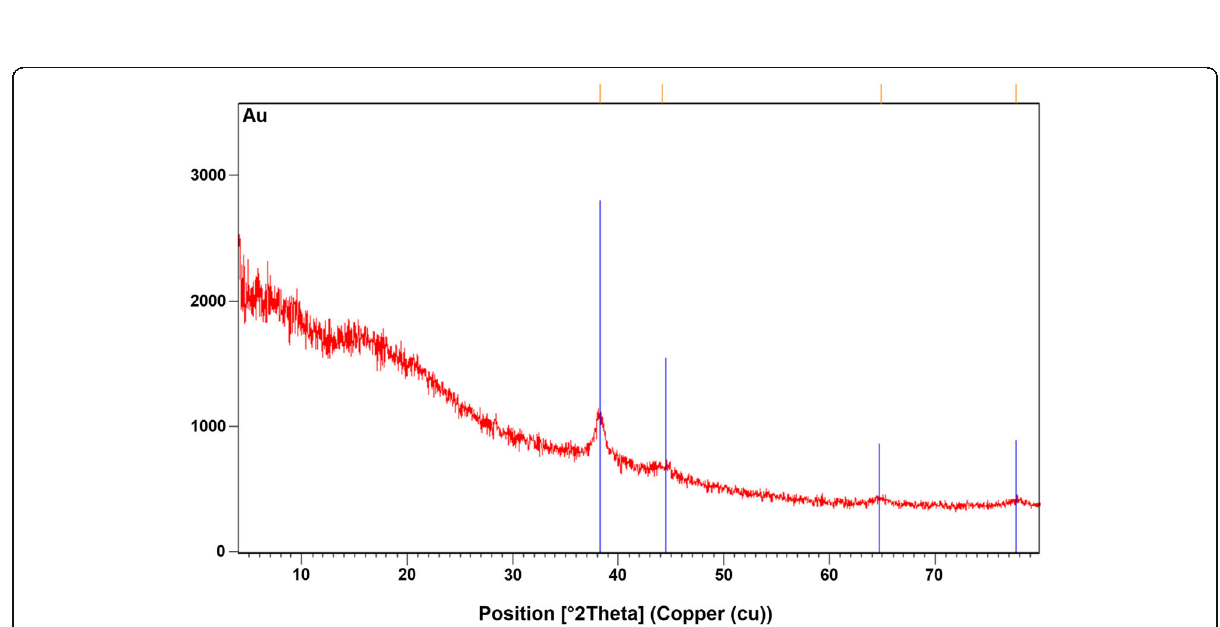
Fig. 5 XRD pattern of the synthesized AuNPs using jujube